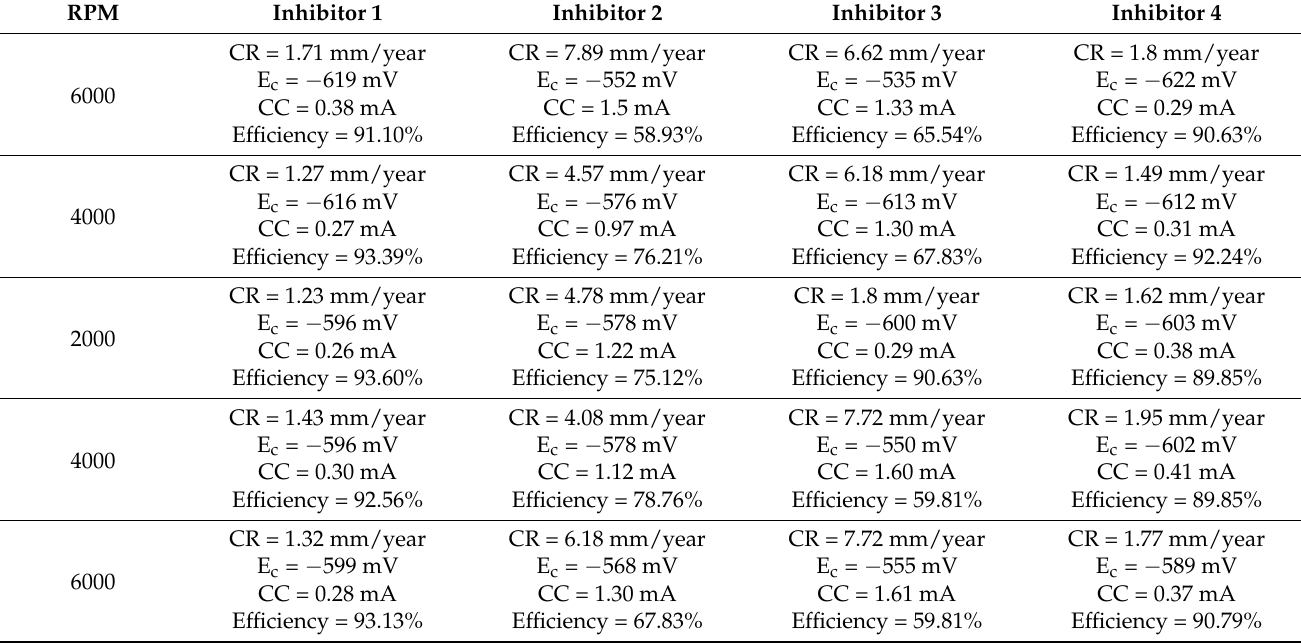
Table 1. Polarization resistance essays in a rotating cylinder in a NACE solution. Corrosion rate (CR) and inhibitor’s efficiency with respect to the general corrosion.